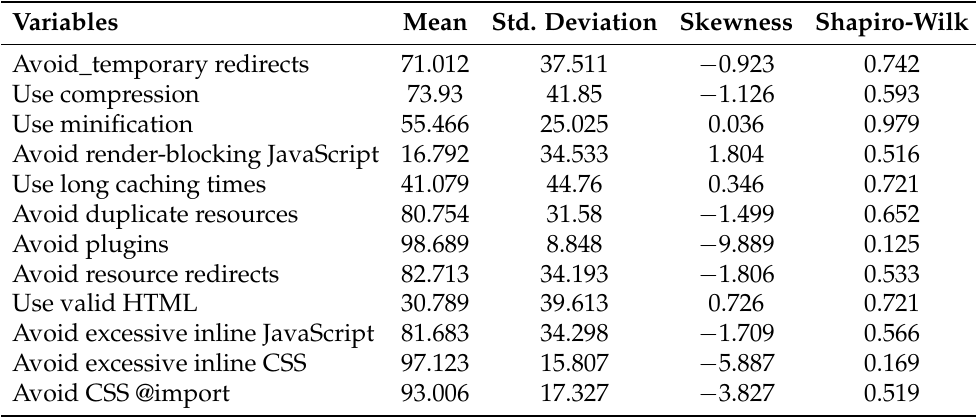
Table 5. Descriptive statistics results for the variables included within Speed factor.